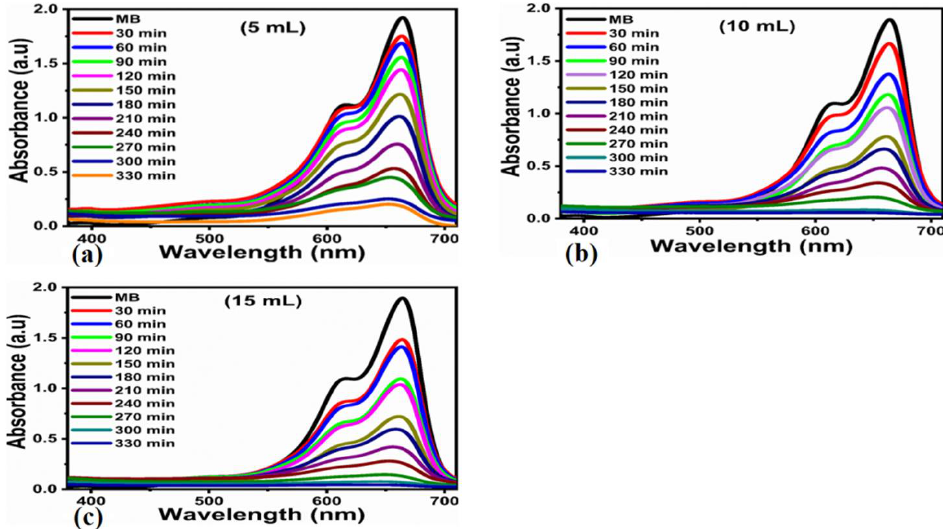
Figure 6. ( a – c ) change in Uv–Vis spectrum for photodegradtion of MB under the natural light illumination over bulk TiO 2 that has been hydrothermally treated with 5, 10, and 15 mL of FC leaf extracts at 30–330 min.